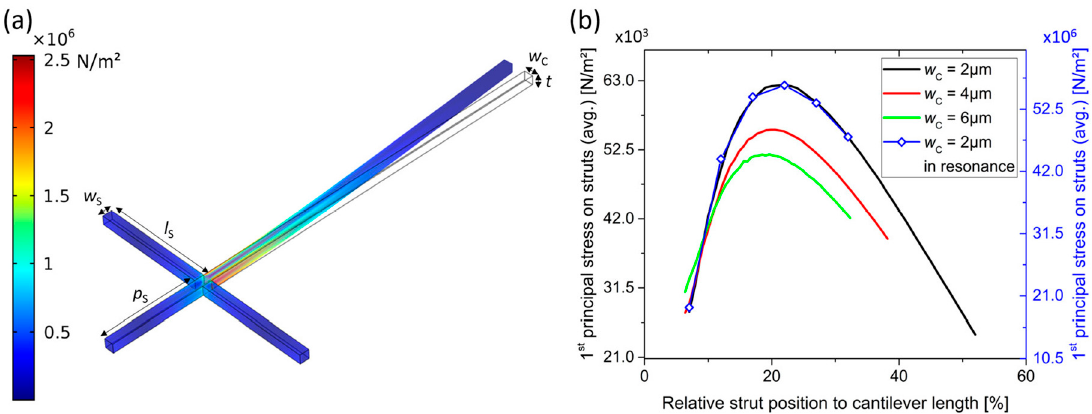
Figure 1. ( a ) Cantilever deflection by FEM upon in-plane excitation with the generated von Mises stress marked by colouring and ( b ) first principle stress on average over a piezo resistive strut vs. strut position along the cantilever